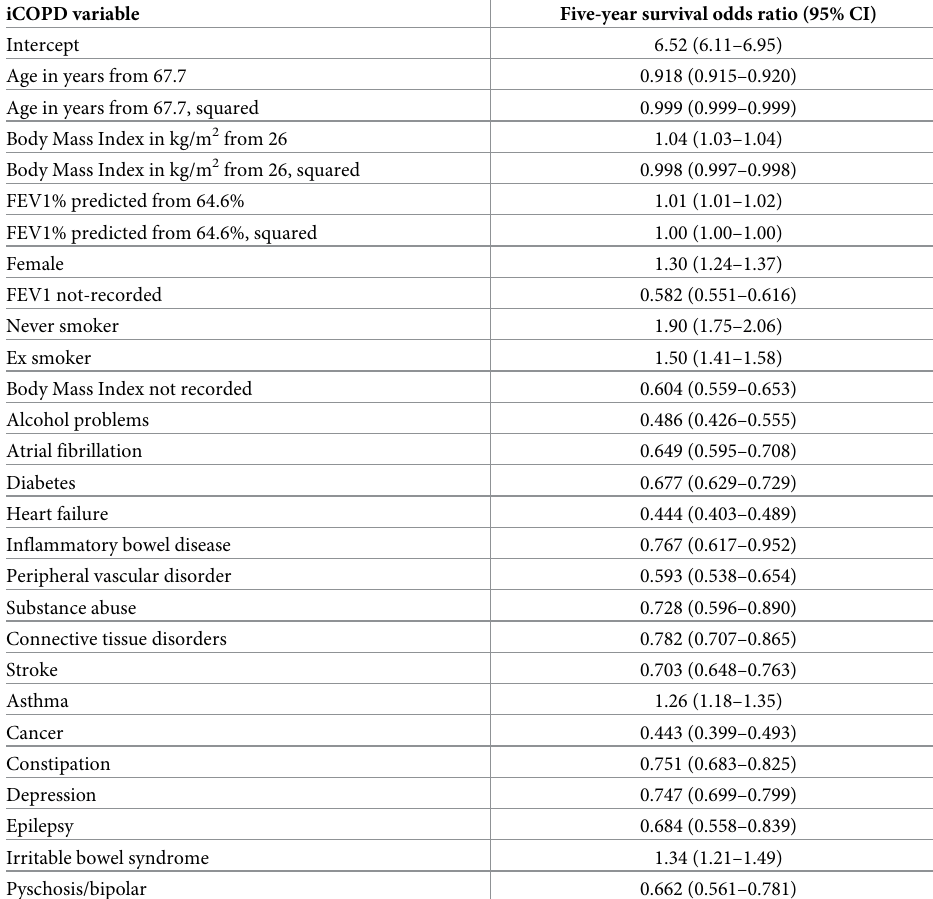
Table 3. Coefficients of the iCOPD model.